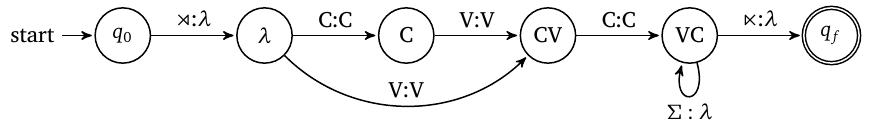
Figure 8: OSL 1-way FST for English nickname formation A significant proportion of segmental phonology can be mod- eled with ISL and OSL functions (Chandlee 2014; Chandlee and Heinz 2018; Chandlee et al. 2018). Long-distance processes in phonology are however neither ISL or nor OSL. For example, Kikongo nasal har- mony (7) requires the higher subclass of Sequential functions (Gainor et al. 2012). In Kikongo, alveolar stops like d or l surface as n if a nasal precedes them anywhere in the input. There can be any number of vowels and consonants intervening between the triggering nasal and the target alveolar (7c). This long-distance information means that the 1-way FST must keep track of whether a nasal consonant was seen anywhere in the input stem before it will output the